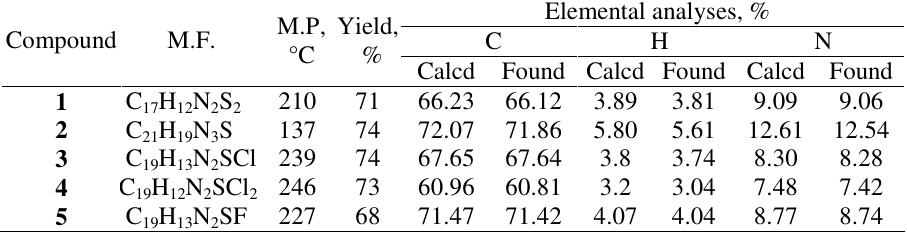
Table 2. Spectral data of the compounds ( 1-5